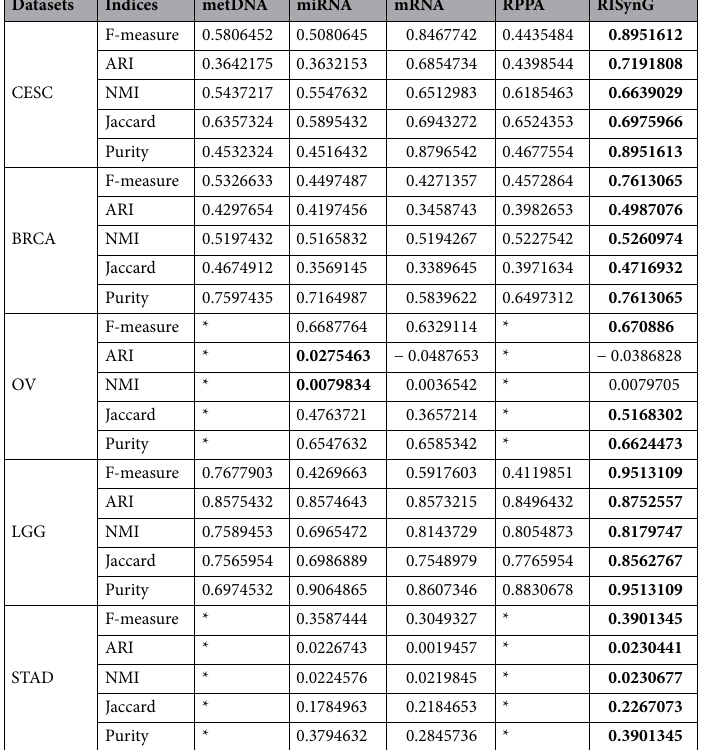
Table 4. Comparative performance analysis of proposed approach and individual omic-view. The bold values indicate the best score as reported in the